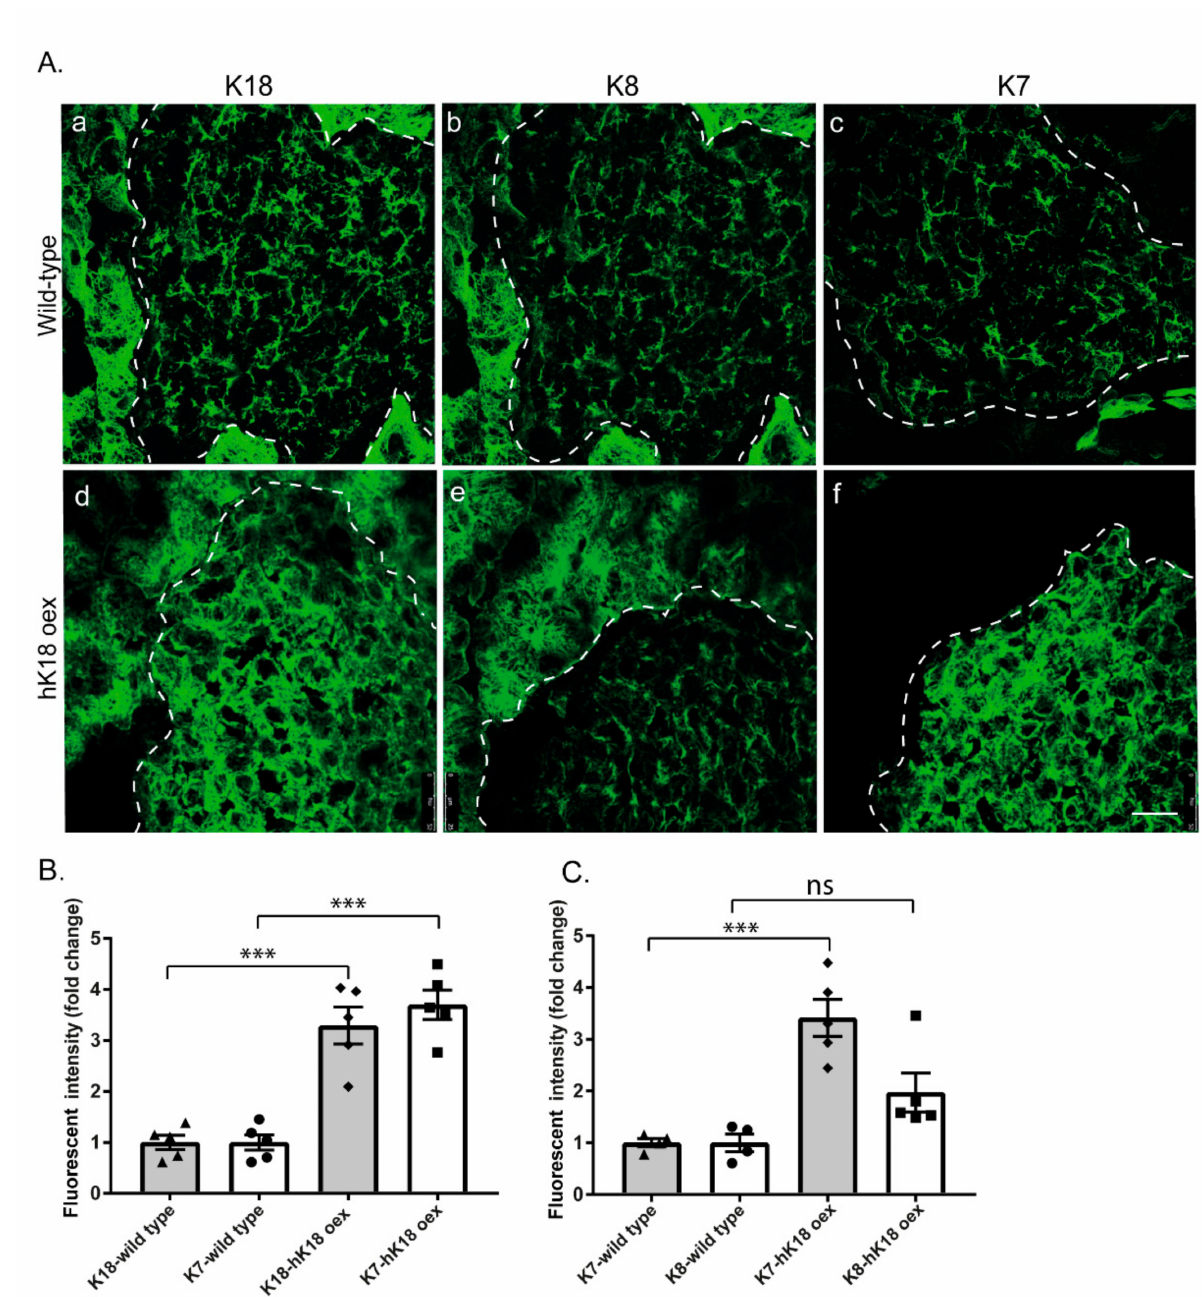
Figure 3. Over-expression of hK18 leads to significant K7 upregulation compared to K8 in mouse pancreatic islets. ( A ) Pancreatic tissue sections of wild-type and hK18 over-expressing mice (hK18 oex) were immunostained for K7, K8 and K18. The individual images labelling keratin filaments in wild-type ( a – c ) and hK18 oex ( d – f ), showed the increase of K18 expression ( d ) as well as a disproportional increase in K7 expression ( f ), compared to K8 ( e ) in islets of hK18 oex as opposed to wild-type islets. Islets are outlined by dotted lines. Scale bar = 50 µ m. ( B ) Quantification of islet K7 and K18 levels from images of immunostained pancreas tissue, indicated a homogenous increase in K7 expression as K18 in hK18 oex mice while ( C ) quantification of K7 and K8 fluorescent intensity, showed a significant increase in K7 level in hK18 oex compared to wild-type and no significant (ns) increase in islet K8. n = 2 mice per genotype with minimally 4 islets analyzed per mouse. *** p < 0.001, t -test is used and error bars represent means ±